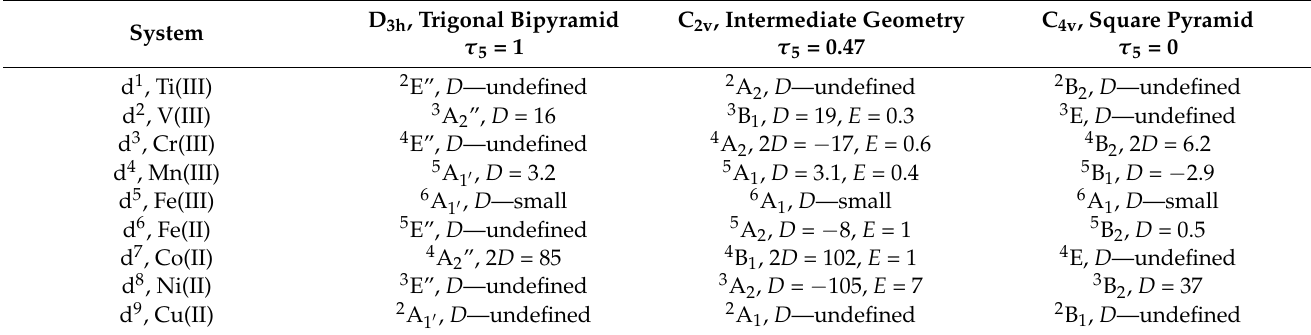
Table 3. Review of the SH formalism for pentacoordinate systems 1 .